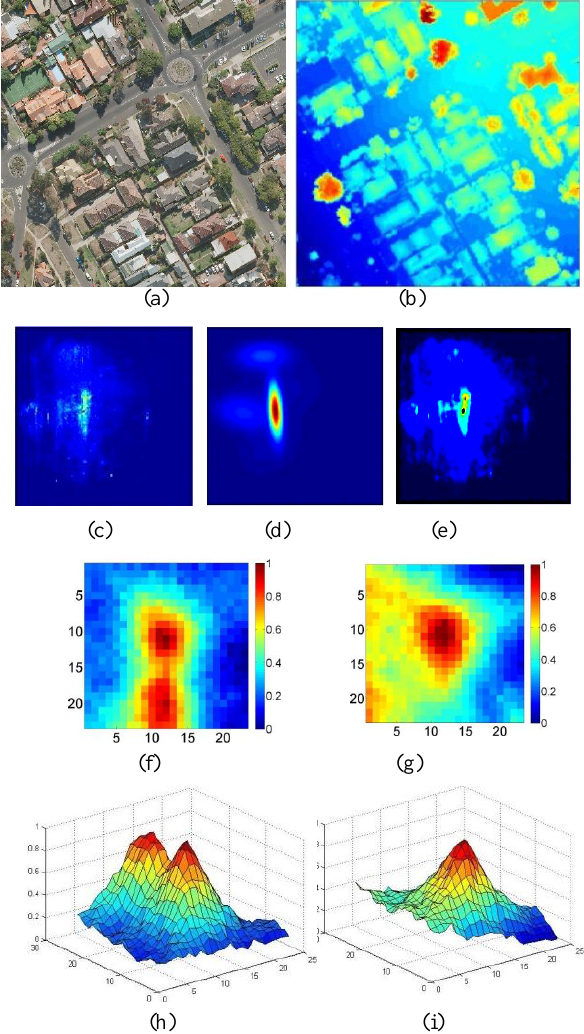
Figure 6. Orthoimage (a), LiDAR DSM image (b), joint distribution (c), GMM weight (d), KDE weight (e), 2D and 3D view of convergence surface of MI(f,h), 2D and 3D view of convergence surface of GWMI